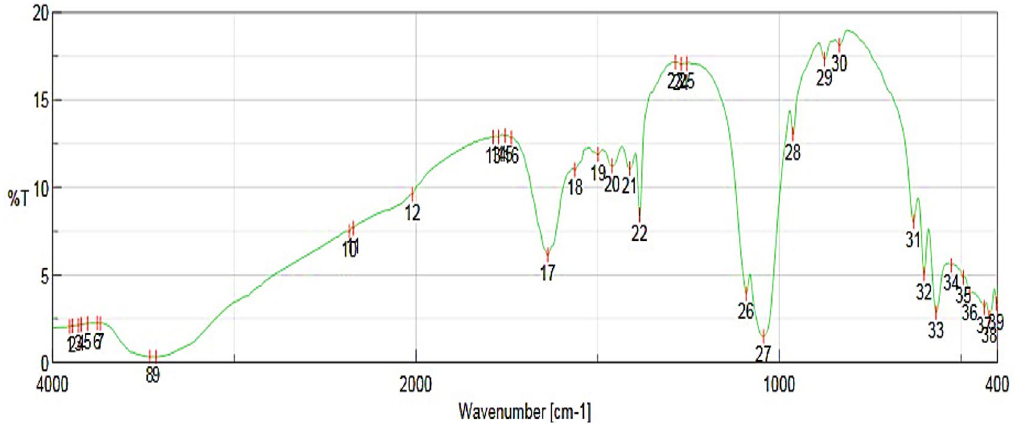
Fig. 8. FT-IR spectra for green synthesized ZnO NPs using A. niger extracellular extract.